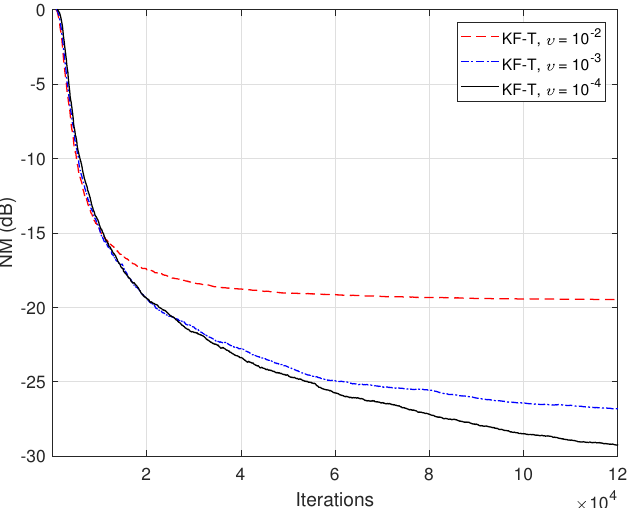
= 0, n = 1,2, . . . , N for the iden- n